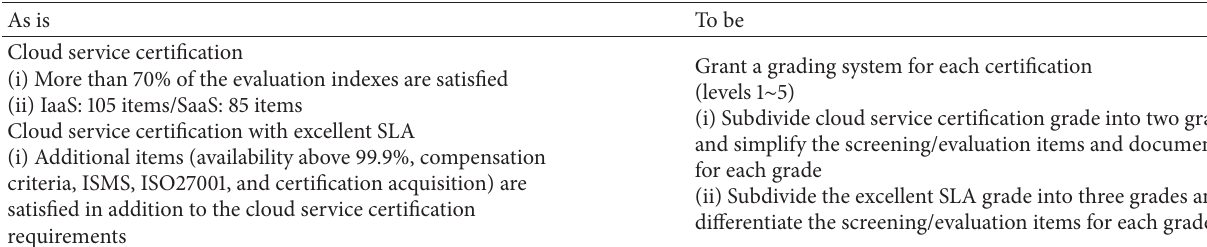
Table 16: Improvement method of certification